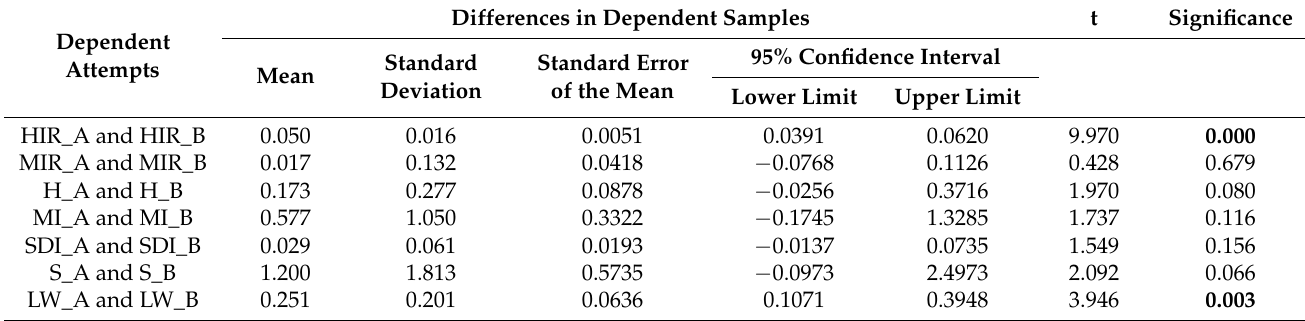
Table 4. Parametric t -test for dependent samples.